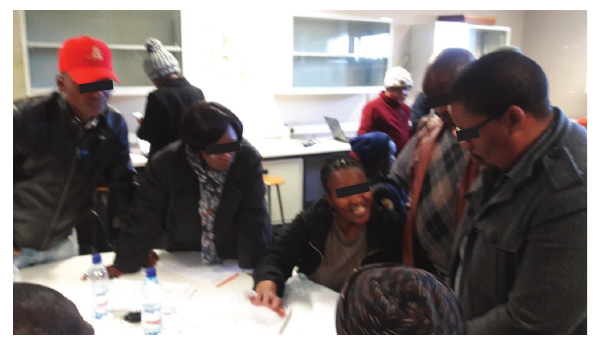
FIGURE 2: Peer collaboration during the workshop.